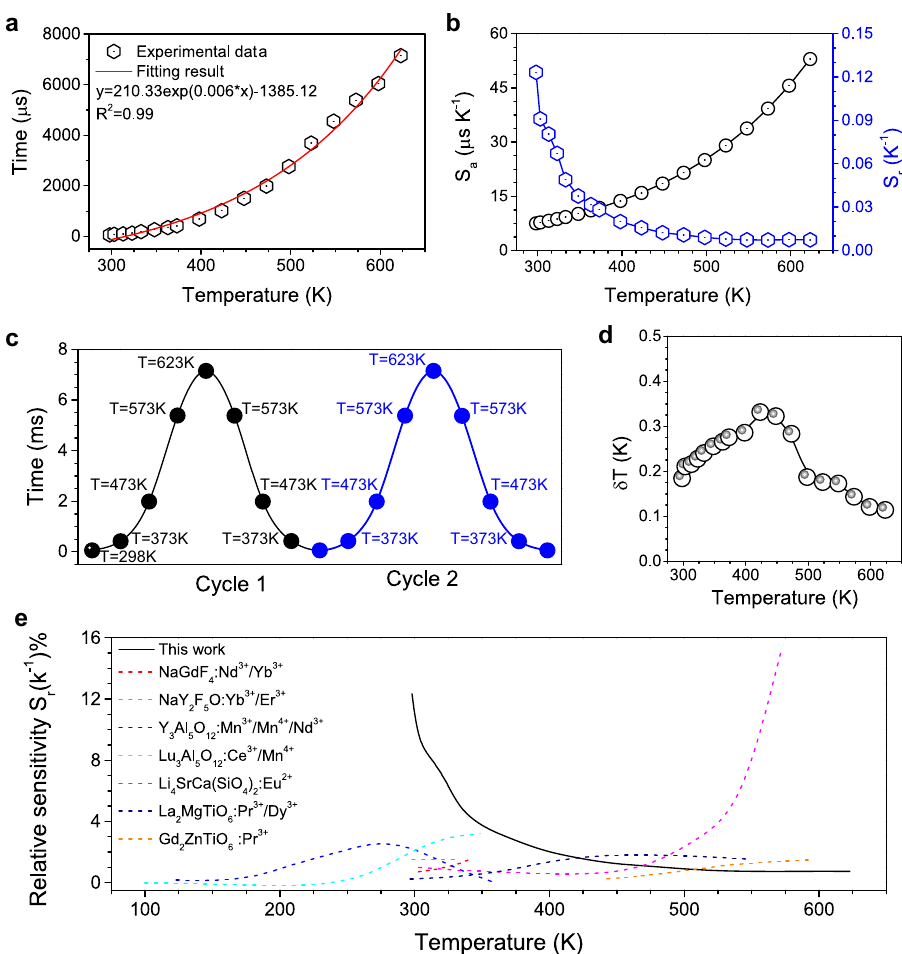
Fig. 6 Lifetime-based luminescence thermometry. a Experimentally measured and exponential fi tted plots of lifetime τ of Sc 2 (MoO 4 ) 3 :20%Yb/1%Er at different temperatures. b Calculated S a and S r versus temperature based on the Sc 2 (MoO 4 ) 3 :20%Yb/1%Er. c Lifetime temperature-recycle measurements 2 cycles of heating and cooling between 298 and 623 K based on the Sc 2 (MoO 4 ) 3 :20%Yb/1%Er. d Temperature uncertainty for Sc 2 (MoO 4 ) 3 :20%Yb/1%Er at different temperatures. e Relative sensitivity (S r ) of Sc 2 (MoO 4 ) 3 :Yb/Er and the state-the-art luminescent thermometers. Different color dotted lines are previous work based on lifetime mode. S r are directly extracted from literature reports: NaGdF 4 :Nd 3 + /Yb 3 + [47] ; Li 3 SrCa(SiO 4 ) 2 :Eu 2 + [48] ; NaY 2 F 5 O:Yb 3 + / Er 3 + [49] ; Y 3 Al 5 O 12 :Mn 3 + /Mn 4 + /Nd 3 + [50] ; Lu 3 Al 5 O 12 :Ce 3 + /Mn 4 + [51] ; La 2 MgTiO 6 : Pr 3 + /Dy 3 + [52] ; Gd 2 MgTiO 6 : Pr 3 + [53]